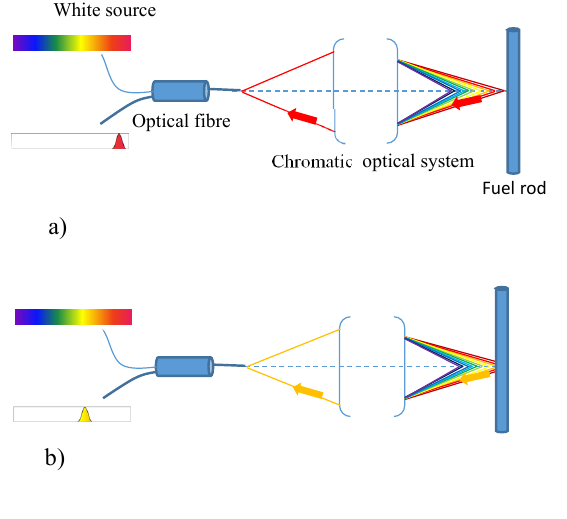
Figure 1: confocal chromatic sensor global principle. a) confocal chromatic in front of a fuel rod before swelling , b) after